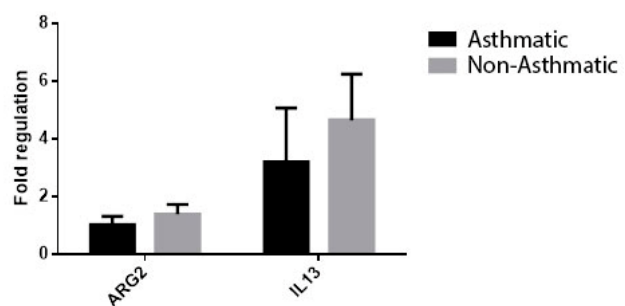
Figure 9. ARG2 and IL-13 expression in patients with CRS: asthmatic vs. non-asthmatic. p = 0.23.